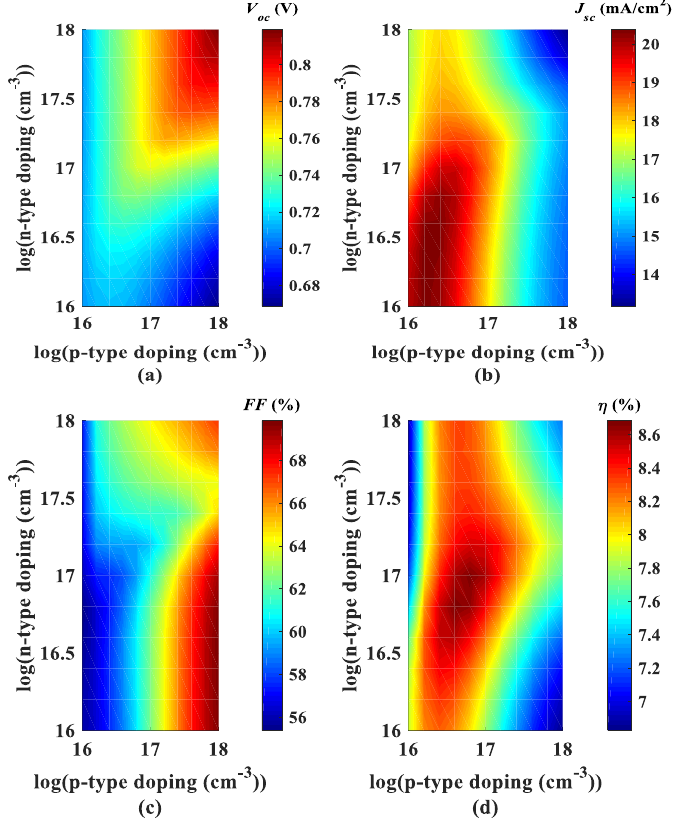
Figure 8. Variations of solar cell performance parameters with the donor concentration N D of n-CH 3 NH 3 SnI 3 and acceptor concentration N A of the p-CH 3 NH 3 SnI 3 ( a ) open circuit voltage, ( b ) short-circuit current, ( c ) fill factor and ( d ) efficiency.